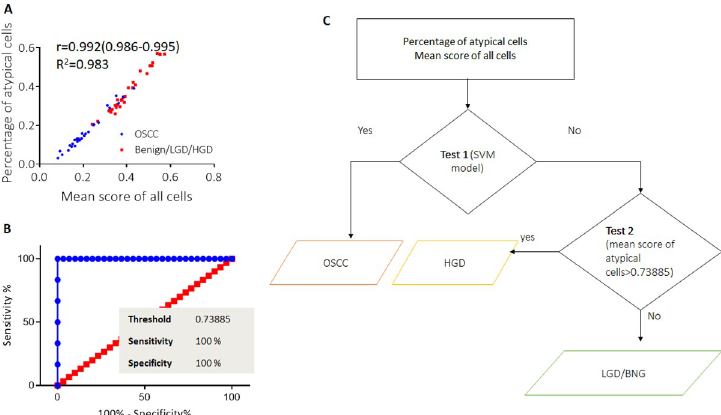
Fig 5. Risk stratification model. Scatter plot (a) representing percentage of atypical cell and mean score of all cells (n = 60) showing high correlation (r = 0.992, CI = 0.986–0.995) and these variables used for test 1, in risk stratification model (SVM). The cut-off value of ROC curve analysis (b) in delineating OSCC from LGD were used in risk stratification model as test 2